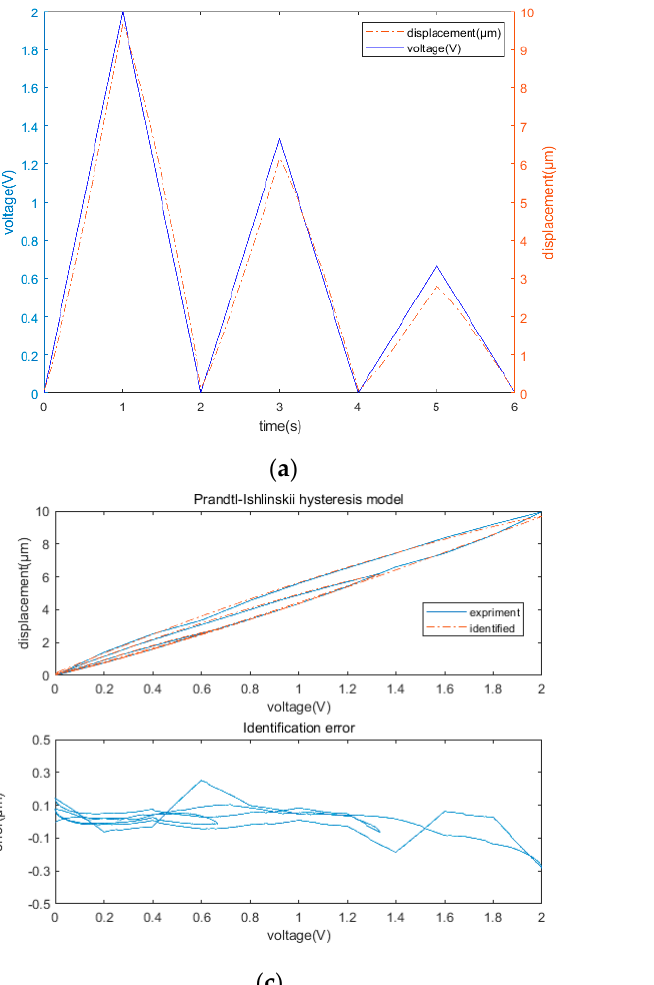
Figure 7. Identification results of the Prandtl–Ishlinskii inverse hysteresis model.